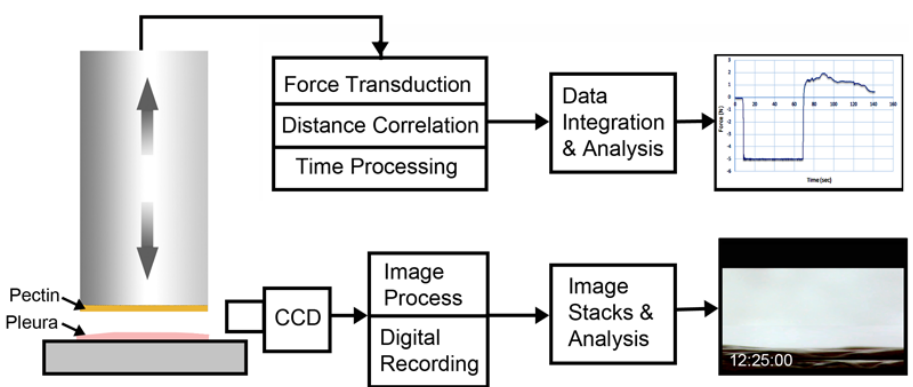
Figure 2. Schematic of pectin–glycocalyceal adhesion testing. The material analyzer (Stable Micro Systems) used custom fixtures to mount pectin films on the cylindrical probe and visceral pleural to the fixture surface. The computer-controlled adhesion test involved probe descent at 2 mm/s until it reached a trigger force of 5N. The 5N force was maintained for a 60-s development time. The probe was then withdrawn at a velocity of 0.2 mm/s. Time, force, and distance were recorded at 500 points per second (pps) and analyzed using the Exponent 6.0 software (Stable Micro Systems) with custom scripts. Due to the complex adhesion process and extensibility of the pleura, simultaneous time-base corrected digital videomicroscopy was performed of the adhesion interface and analyzed using MetaMorph 7.1 software (Molecular Devices).